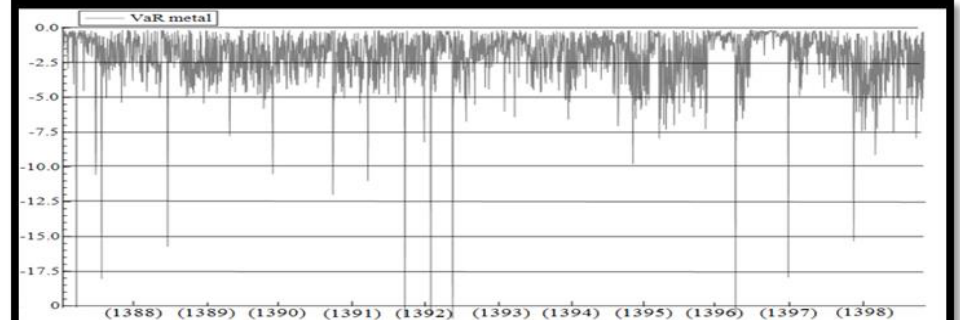
Figure 1. VaR of the metal products